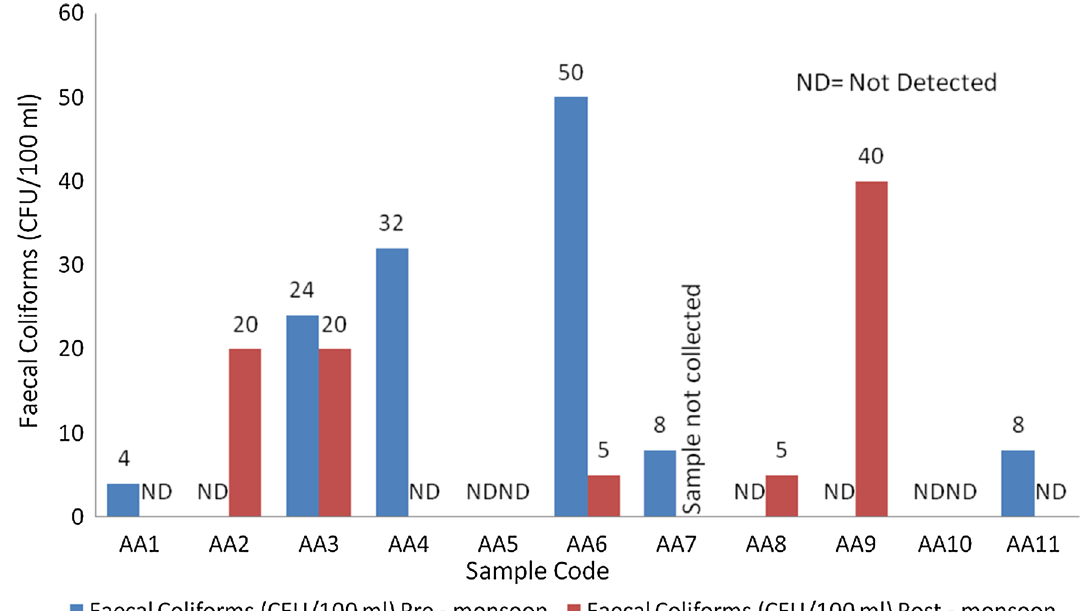
Fig. 12 Faecal coliforms in samples collected from Ayodhya Kunj